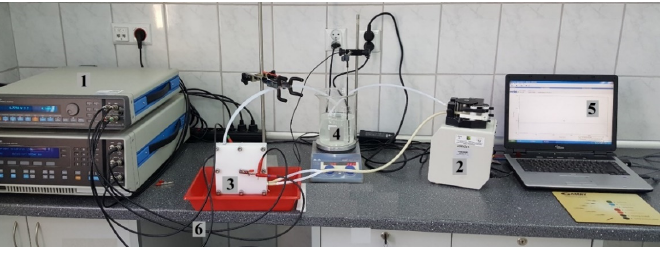
Figure 1. Single-cell measuring system of a laboratory polypropylene (PP)-made alkaline water electrolyser (cell’s dimensions: 15 × 15 × 3.5 cm, including electrodes: 10 × 10 × 0.16 cm), where: 1 is Solartron 12,608 W electrochemical measuring system, 2 is Gilson Minipuls 3 peristaltic recirculation pump, 3 is electrolyser cell, 4 is laboratory electrolyte heater, 5 is control laptop computer and 6 are electrical